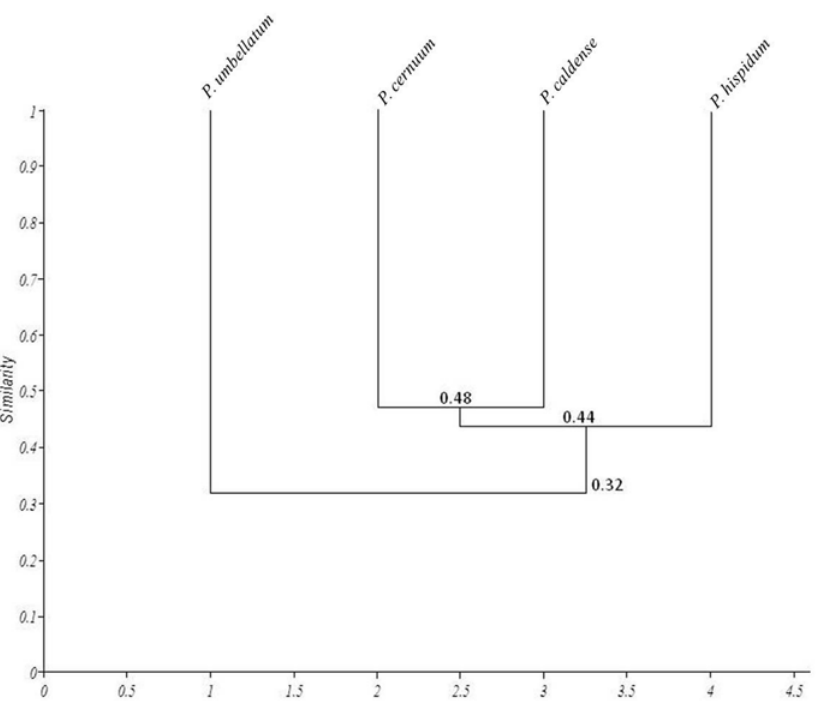
Fig. 3. Bray-Curtis similarity dendrogram comparing the ant assemblages according with their occurrences on four species of the genus Piper : P. caldense ; P. hispidum ; P. cernuum and P. umbellatum . Serra Bonita RPPN, Bahia, Brazil, September 2010 – May